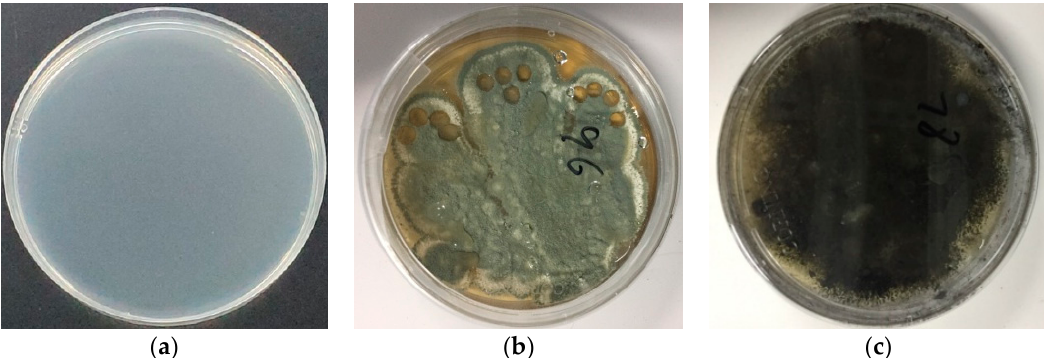
Figure 2. Cultured molds: ( a ) culture medium without mold; ( b ) Penicilliumex pansum ; and ( c ) Aspergillus niger . Conditions: culture at 25 °C for 5 days; dish: 90 mm.